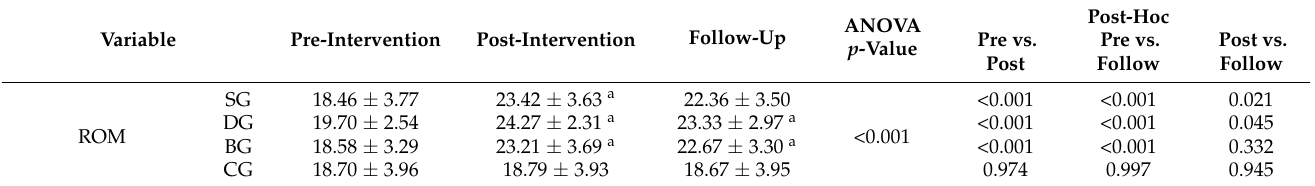
Table 5. Ankle joint